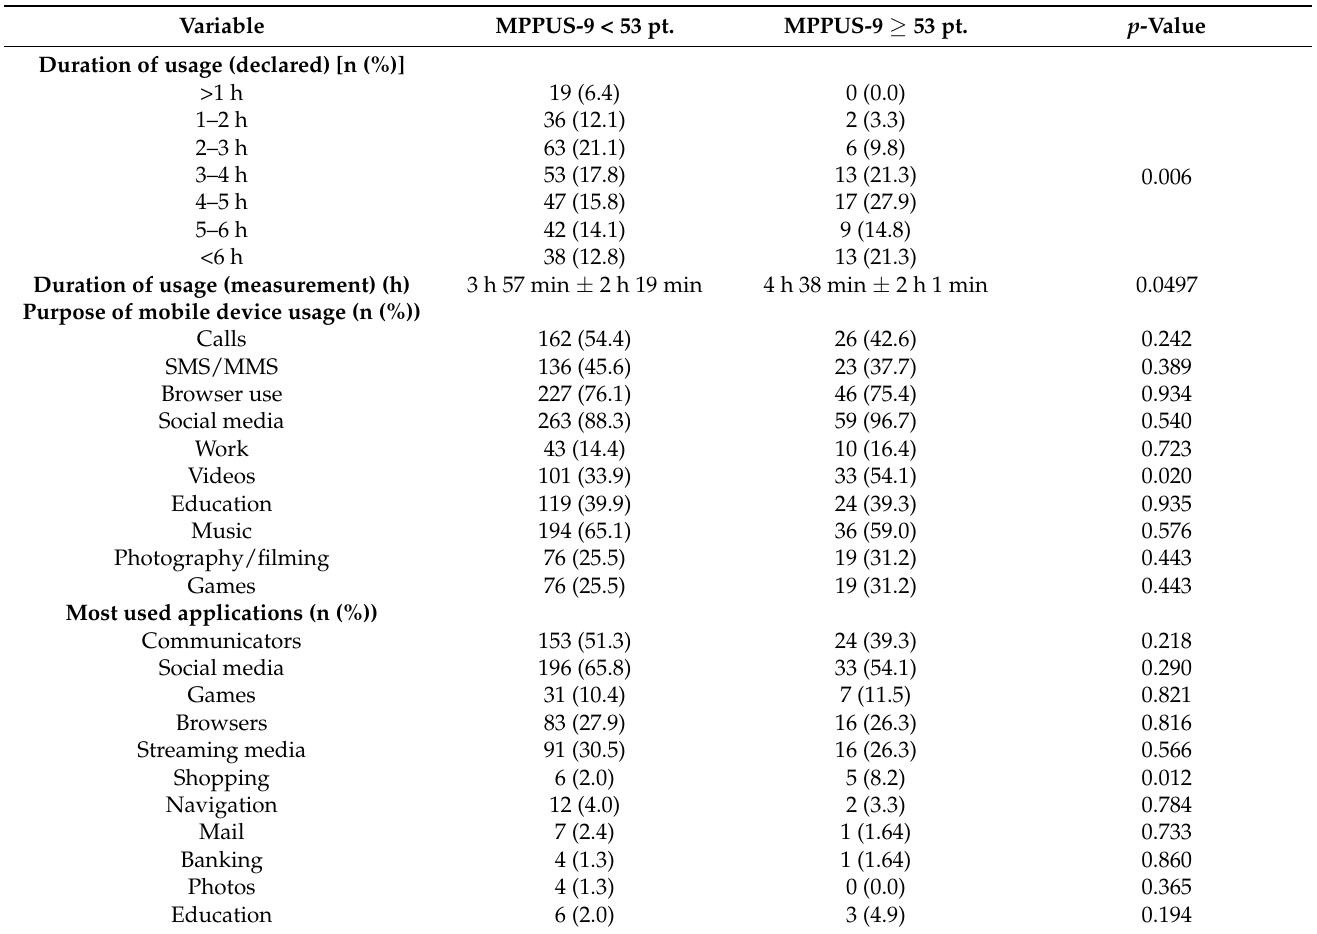
Table 5. Group comparison between individuals that meet the criteria for phonoholism (MPPUS-9 ≥ 53) and a group of participants that does not meet the criteria for phonoholism (MPPUS-9 < 53) regarding the pattern of smartphone usage. Mann–Whitney U test was performed for quantitative variables and Fisher’s exact test was performed for qualitative